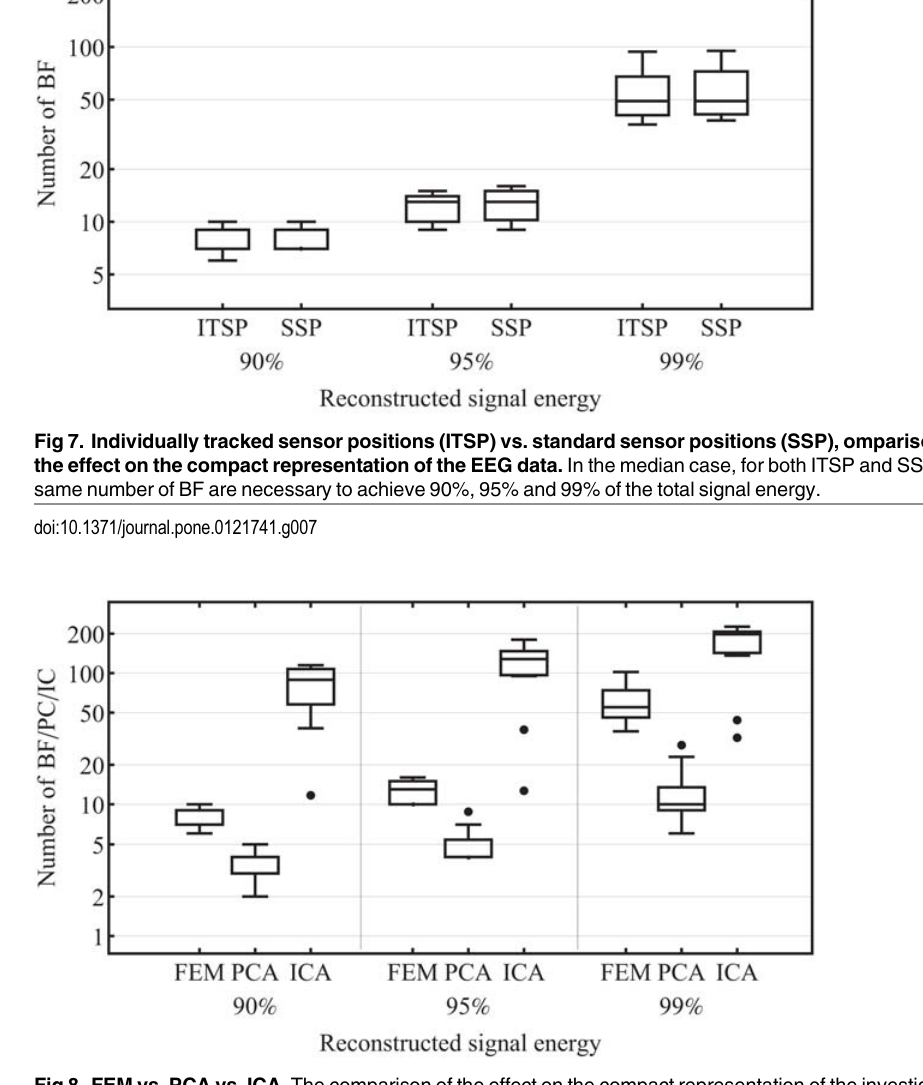
Fig 8. FEM vs. PCA vs. ICA. The comparison of the effect on the compact representation of the investigated EEG